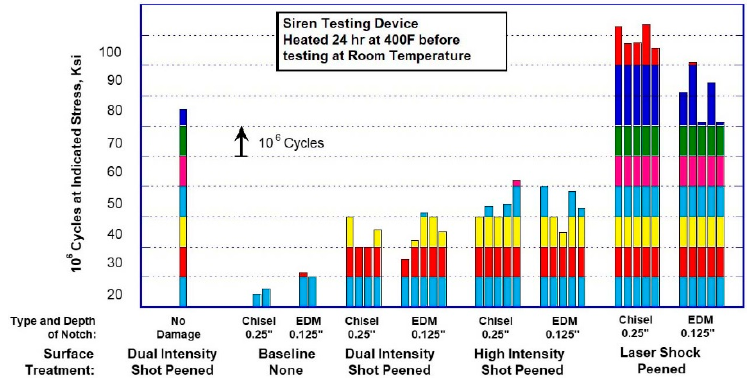
Figure 18. Fatigue strength of F101 fan blades comparing the influence of various surface treatments for protecting against the loss of fatigue strength from foreign object damage.